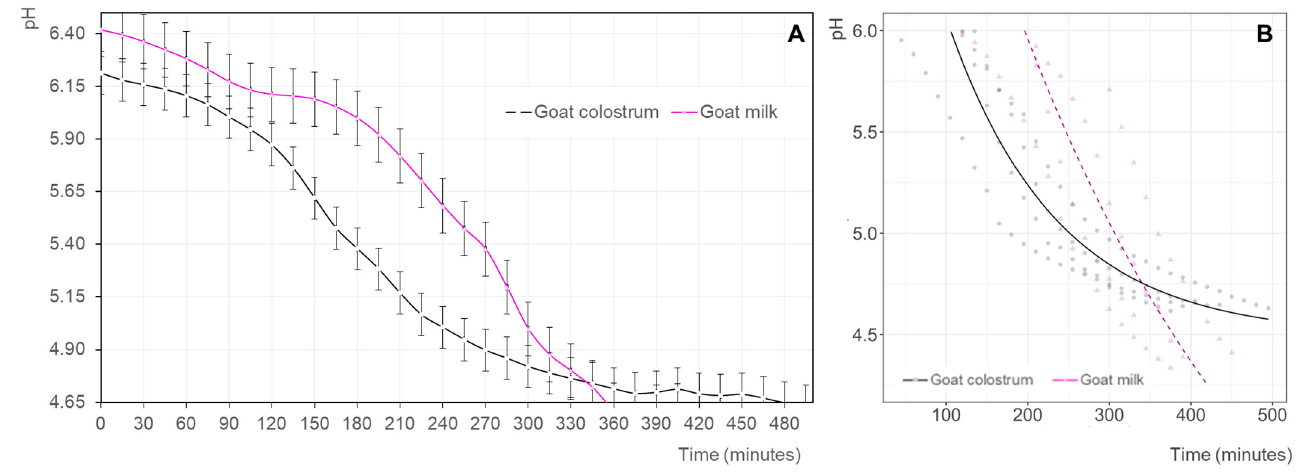
Figure 1. ( A ) Evolution of the pH (mean values ± standard deviation) of the goat milk (pink line) and goat colostrum (black line) inoculated with yogurt starter cultures during fermentation. ( B ) Non-linear mixed regression model of yogurt acidification (pH) predicted for goat milk (dashed pink line; triangle: raw data) and goat colostrum (black line; circles: raw data). The induction period was removed for the fermentation of milk and colostrum in the modeling of the data. Table 2. Coefficients and statistics of an exponential asymptotic mixed linear model on pH control- ling for product (milk, colostrum). The product reference is milk. Asym represents the horizontal asymptote; R0 is pH at t = 0; lrc is the natural logarithm of the rate constant.